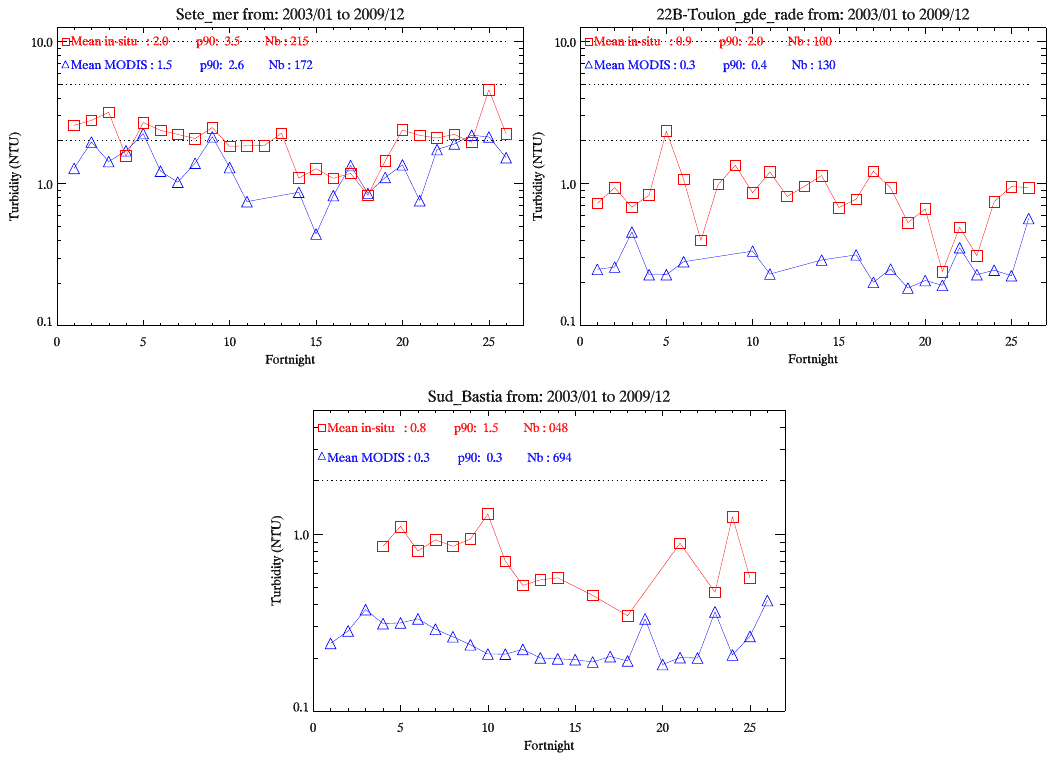
Fig. 13. The annual cycles of turbidity at the selected stations of the Mediterranean coast.